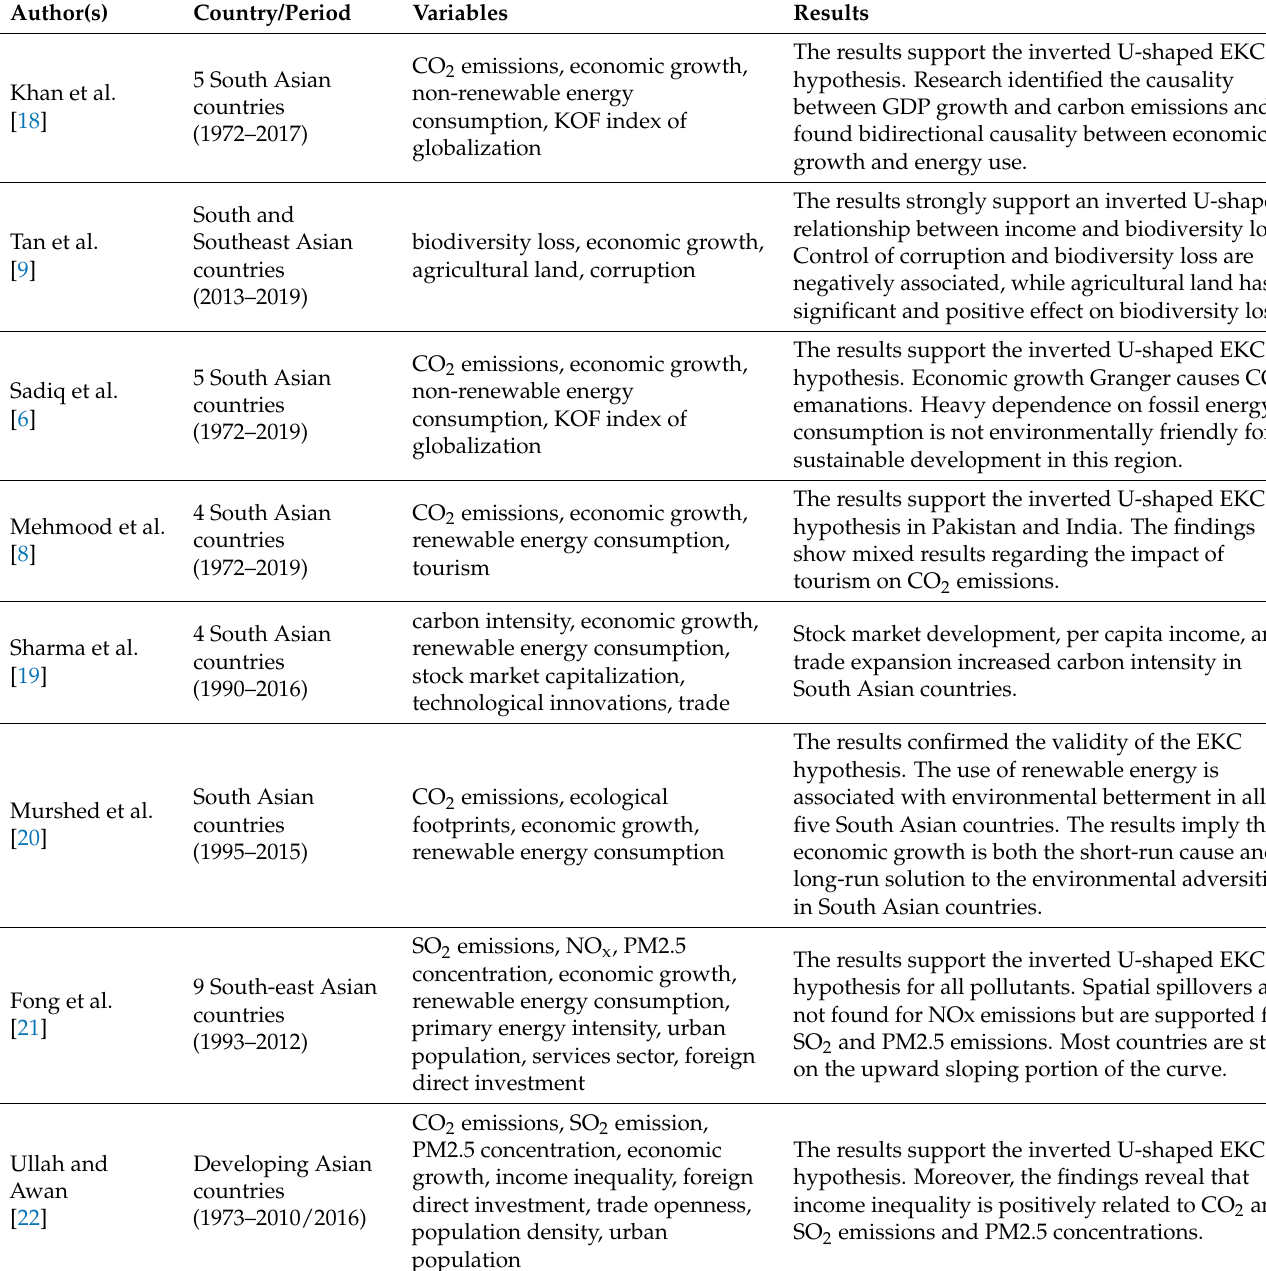
Table 1. Literature review on environmental degradation in South Asian countries. Recently pub- lished